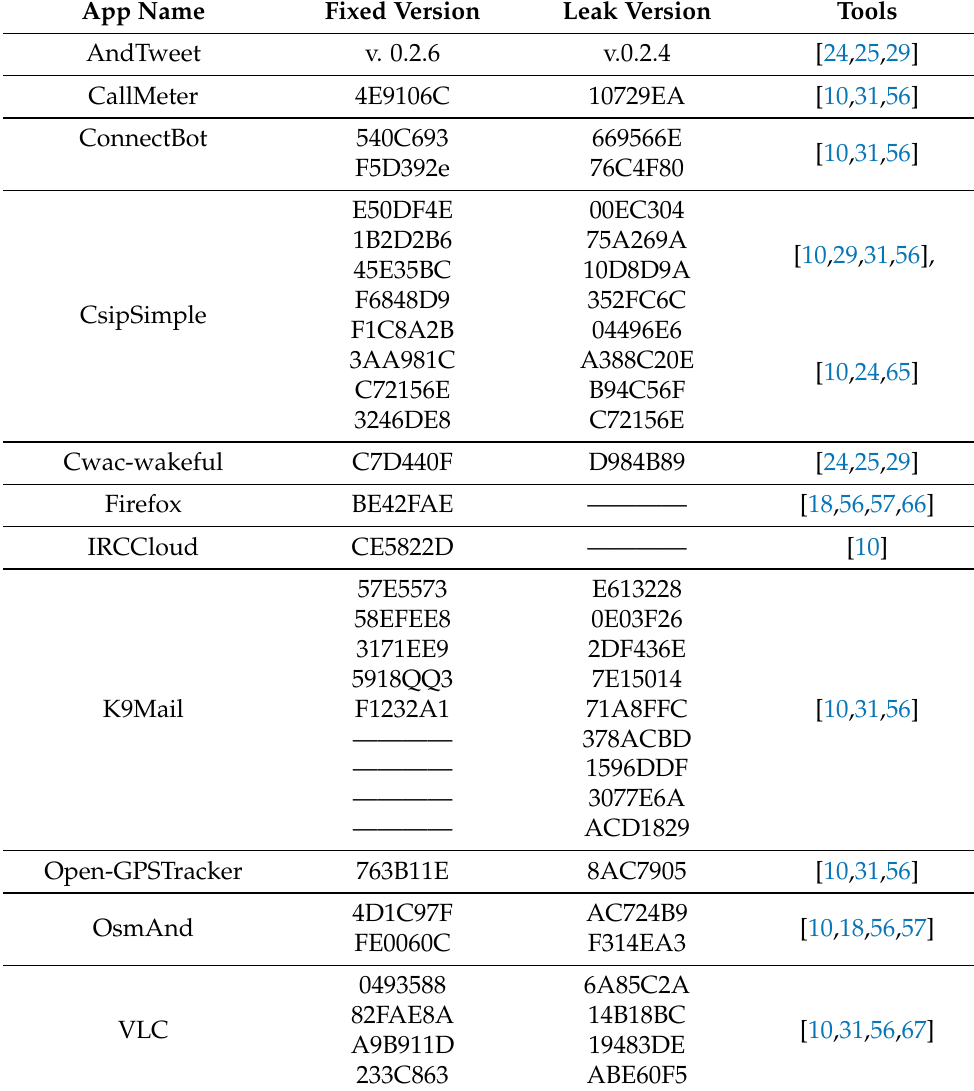
Table 2. Applications having the wake lock leak problem and tools they were